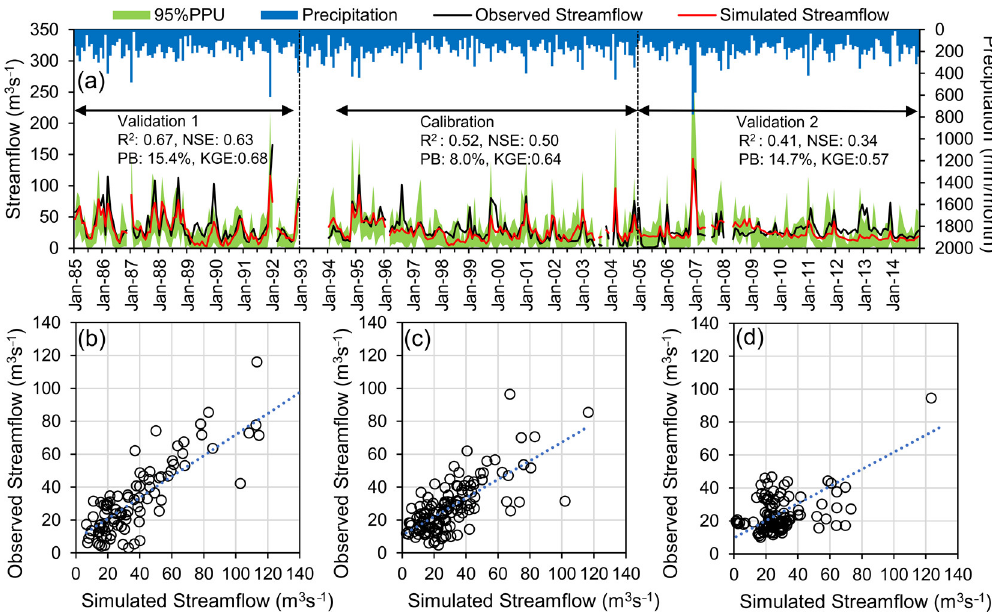
Figure 2. ( a ) SWAT calibration and validation at the Rantau Panjang station for monthly streamflow from 1985 to 2014, and comparisons between observed and simulated streamflow for ( b ) validation 1, ( c ) calibration and ( d ) validation 2 periods.